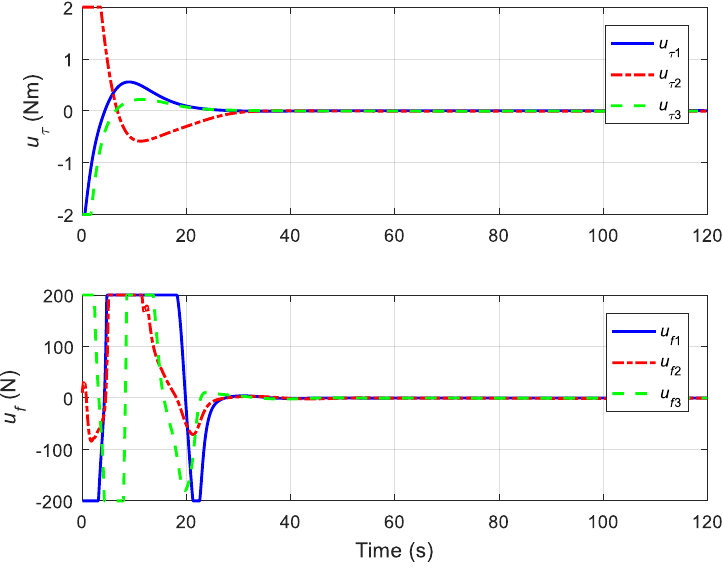
Figure 6. Control torques and forces of the chaser under the proposed controller.